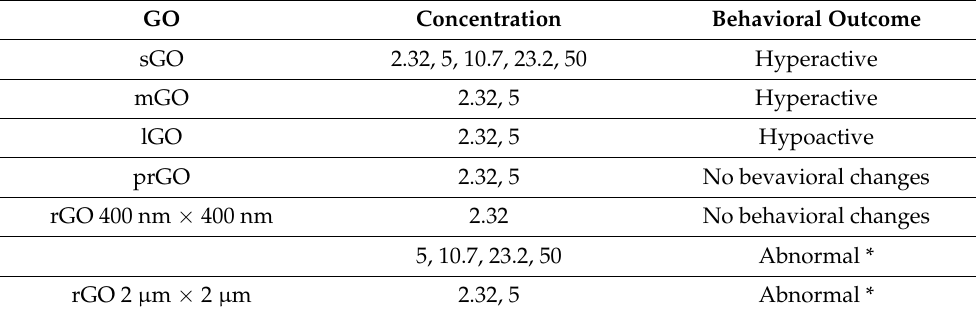
Table 2. Summary of Behavioral outcomes in response to GO exposures. Tabulated summary of the behavior effects that were recorded in graphical form (see Figures S2 – S4) obtained when the em- bryos were 5 dpf. An asterisk (*) indicates that the activity level is dependent on the concentration that the embryos were exposed to at 6 hpf.